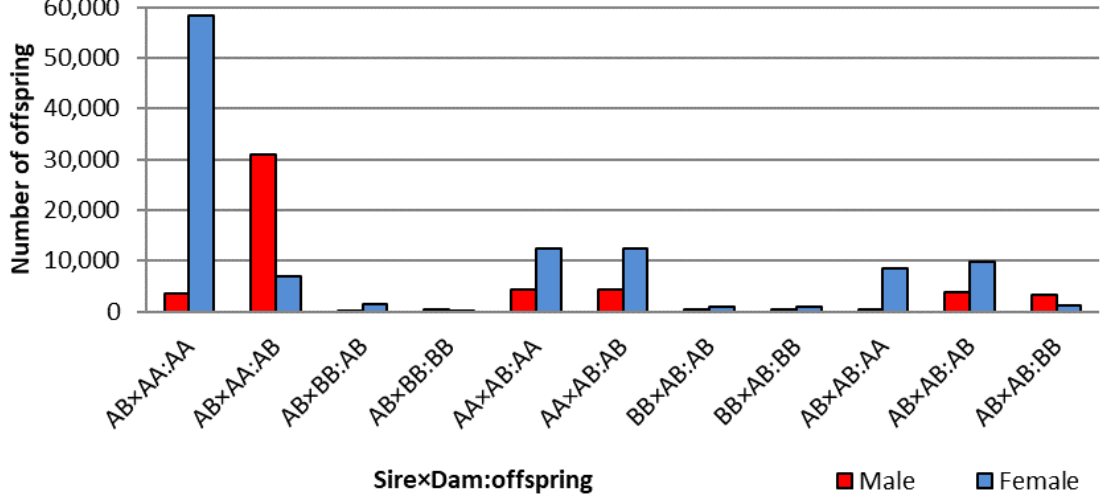
Figure 3. Distribution of male and female offspring for informative mattings for the SNP with highest BF with opposite sire-TRD between sex offspring.